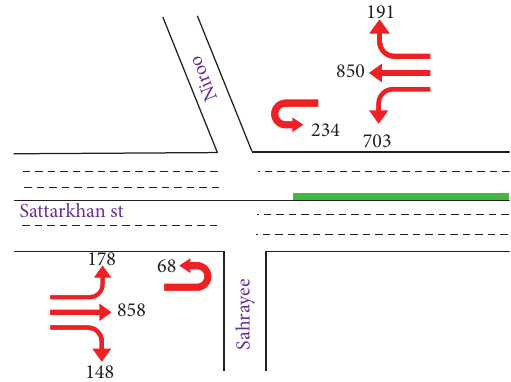
Figure 2: Sattarkhan intersection with passing volumes at the peak hour (vehicles per